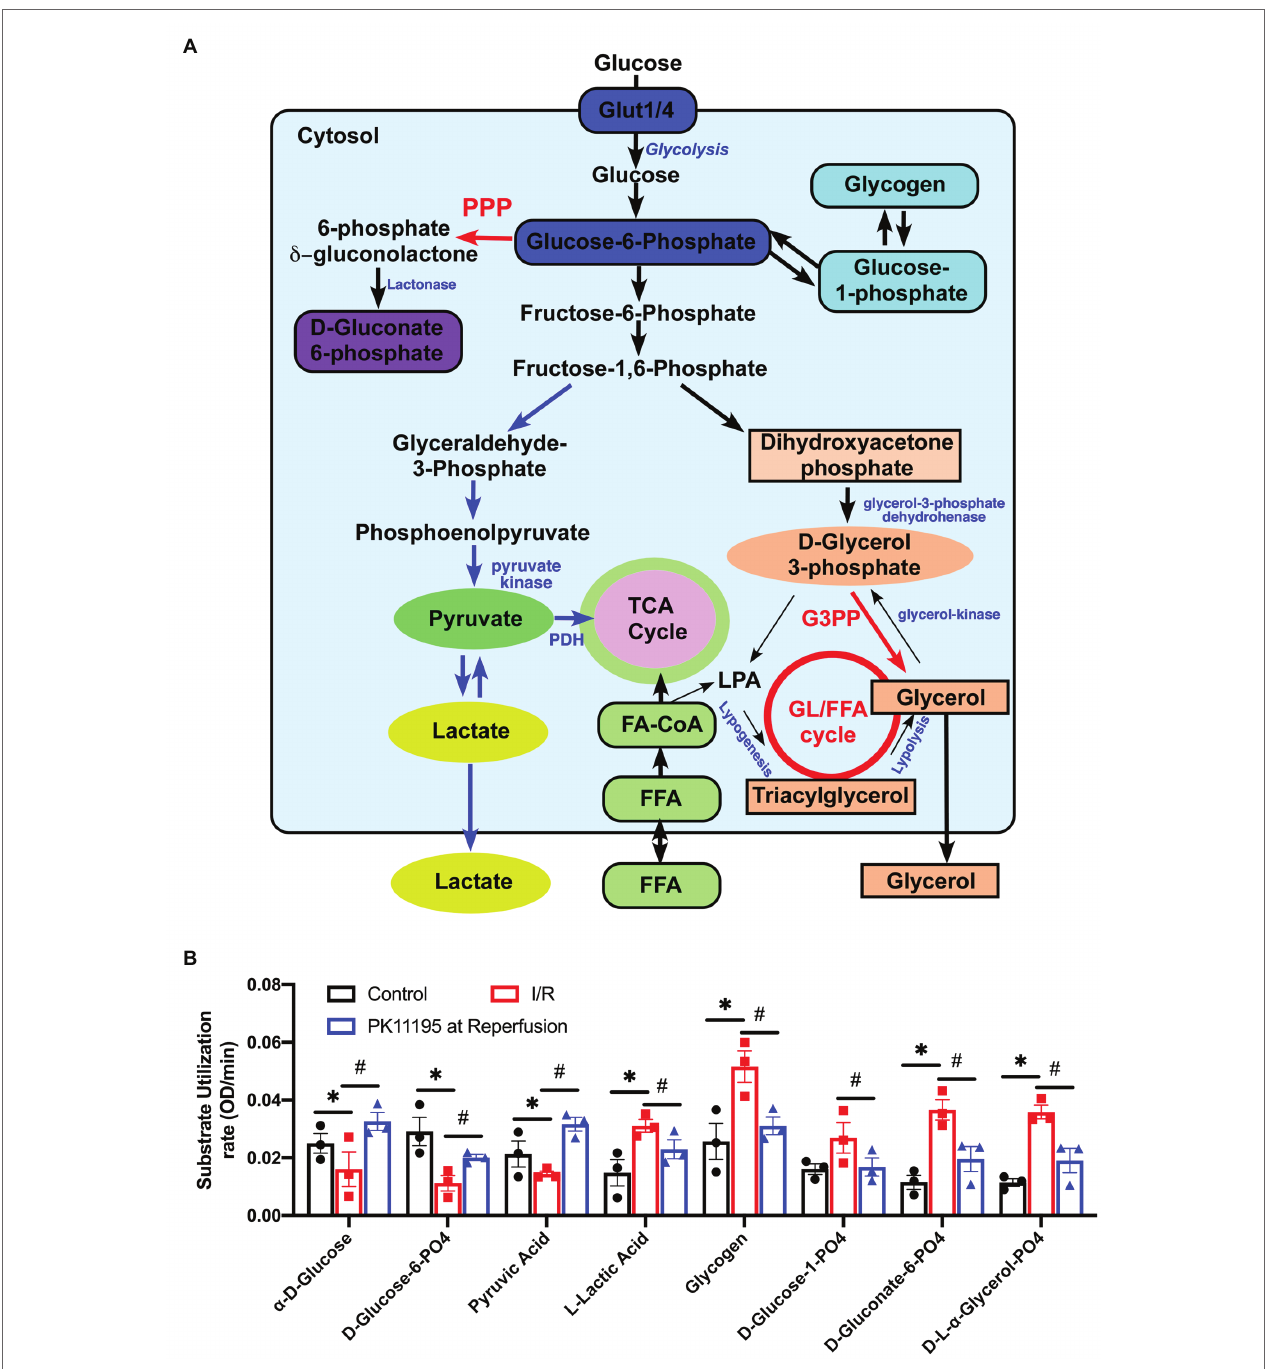
FIGURE 5 | Changes in utilization of glycolytic substrates and intermediates in untreated rabbit cardiac myocytes, and cardiomyocytes exposed to simulated I/R in the absence or presence of 50 μ M PK11195. (A) Schematic representation of the intermediates of glycolysis, pentose phosphate pathway, glycogenolysis, and the gluconeogenesis pathway. GL/FFA cycle, glycerolipid/free fatty acid cycle; LPA, lysophosphatidic acid; 3GPP, glycerol- 3-phosphate phosphatase; PPP, pentose phosphate pathway, PDH, pyruvate dehydrogenase. (B) Shown are changes in utilization of the intermediates involved in glycolysis, pentose phosphate, glycogenolysis, and the gluconeogenesis pathways measured with Biolog MitoPlates. Control rabbit cardiomyocytes were exposed to 20 min of simulated ischemia and then exposed to simulated reperfusion in the absence or presence of 50 μ M PK11195. Data presented as mean ± SEM obtained from three different animals per each group. * p < 0.05 reflects a significant difference in intermediate utilization between control cardiomyocytes and cardiomyocytes exposed to simulated I/R; # p < 0.05 reflects a significance between PK11195 treated cardiomyocytes subjected to simulated I/R vs. cardiomyocytes exposed to I/R in the absence of PK11195. There was no difference between control and PK11195 at reperfusion